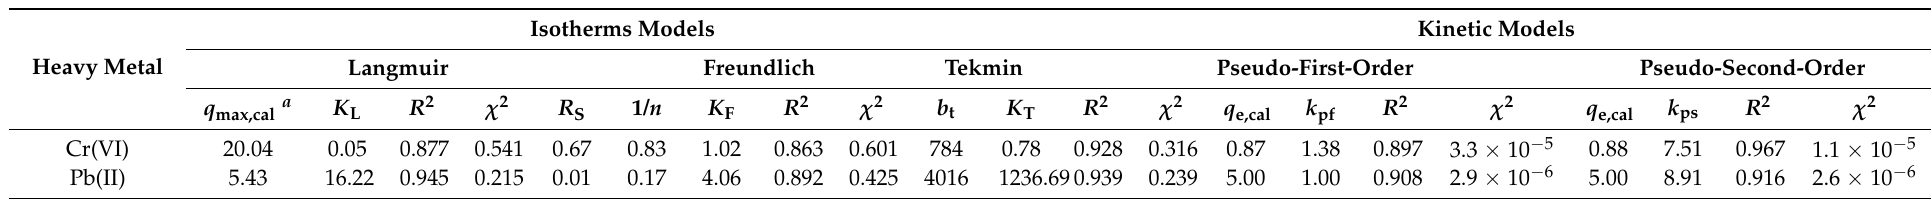
Table 3. The calculation parameters of adsorption equilibrium isotherm models and kinetic models. The definition of the model parameters and their units are explained in the List of Symbols and Units. The tested adsorbent is 10Ch600.60K 2 CO 3 .U. Conditions: Cr(VI) and Pb(II) C i: 10–70 mg/L; AC dose: 10 g/L; Cr(VI) pH: 2, Pb(II) pH: 6; the contact time: 1 h; and T: 25 ◦